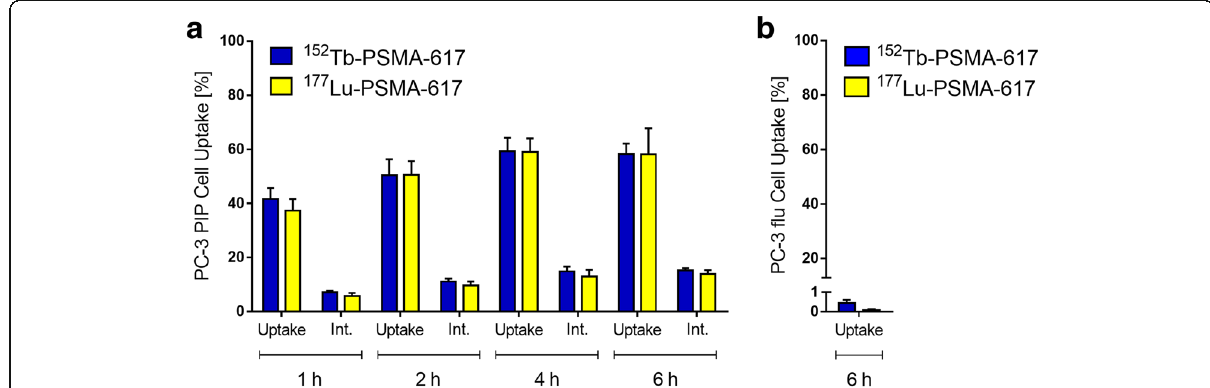
Fig. 1 Uptake and internalization of 152 Tb-PSMA-617 (blue) compared to 177 Lu-PSMA-617 (yellow) in a PSMA-positive PC-3 PIP tumor cells and b PSMA-negative PC-3 flu tumor